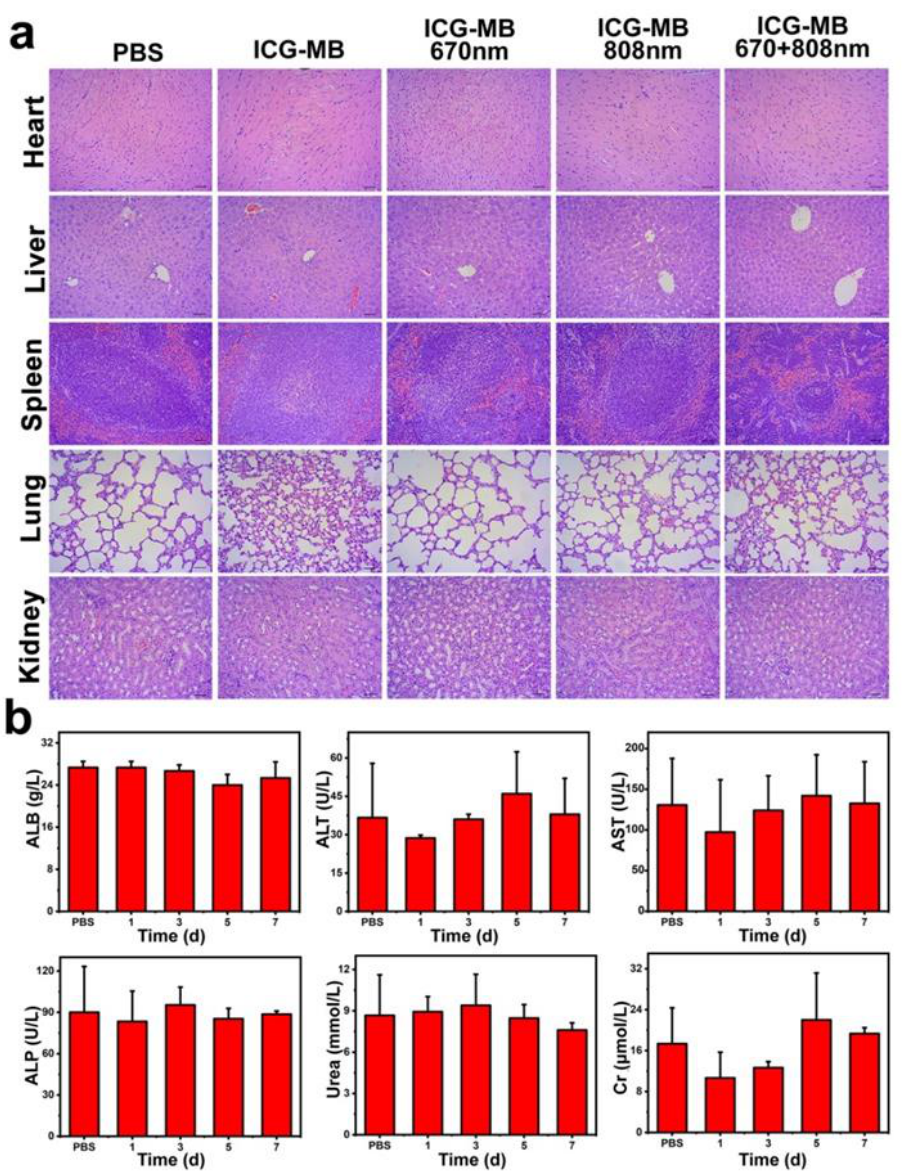
Figure 8. ( a ) H&E staining images of major organs collected from mice after various treatments. Scale bar: 50 μm. ( b ) Serum biochemistry results obtained from mice injected with ICG-MB and mice not injected.